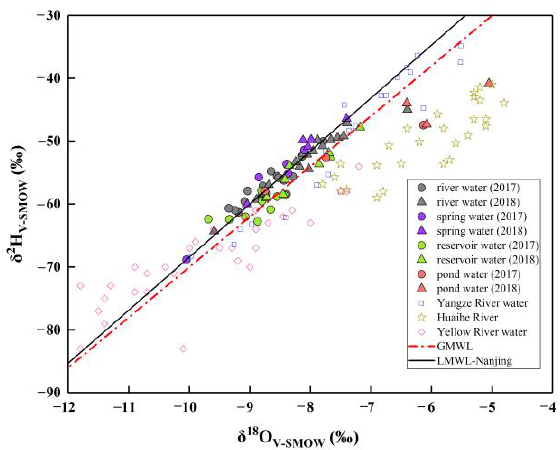
Figure 3. Scatterplots of δ 2 H and δ 18 O in the UPRB, the Yangtze River [33], the Huaihe River [20], and the Yellow River [34], and the correlation with the Global Meteoric Water Line (GWML) [32] and Local Meteoric Water Line of Nanjing (LMWL-Nanjing) [21] .